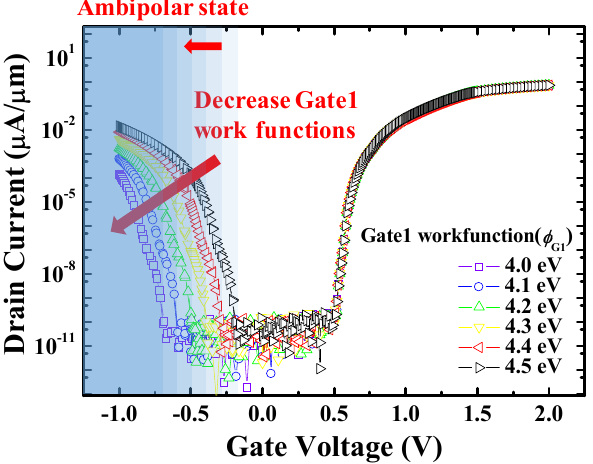
Figure 5. Transfer curves of stacked gate L-shaped TFET with various ϕ G1 (at V DS = 0.7 V). As ϕ G1 decreases, ambipolar current is suppressed more and also ambipolar state region contracts. It can be interpreted as if only the left part of the transfer curve ( V GS < 0) is shifted to the left.